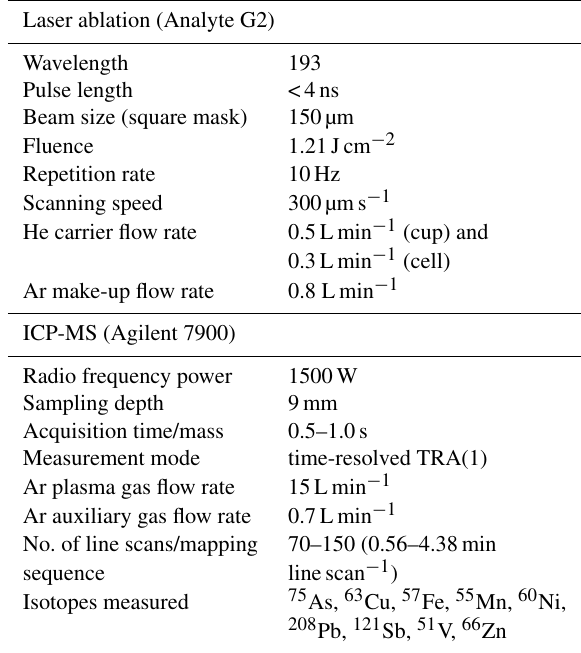
Table 1. Optimized operating conditions for the laser ablation ICP- MS system.